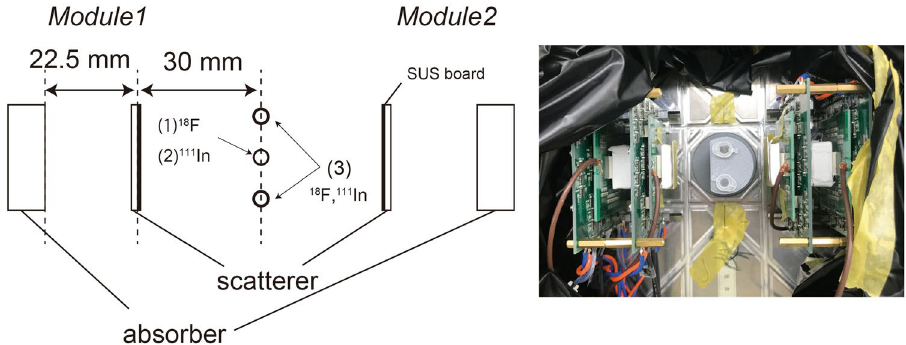
Figure 8. Experimental setup. Two scatterer–absorber modules were placed in opposing positions. The distance between the source and the surface of a scatterer was 30 mm, and the distance between the surface of a scatterer and that of an absorber was 22.5 mm. For the basic performance experiments, radionuclide sources were placed in the center between the two modules. SUS boards were placed in front of each scatterer to shield it from the 111 In